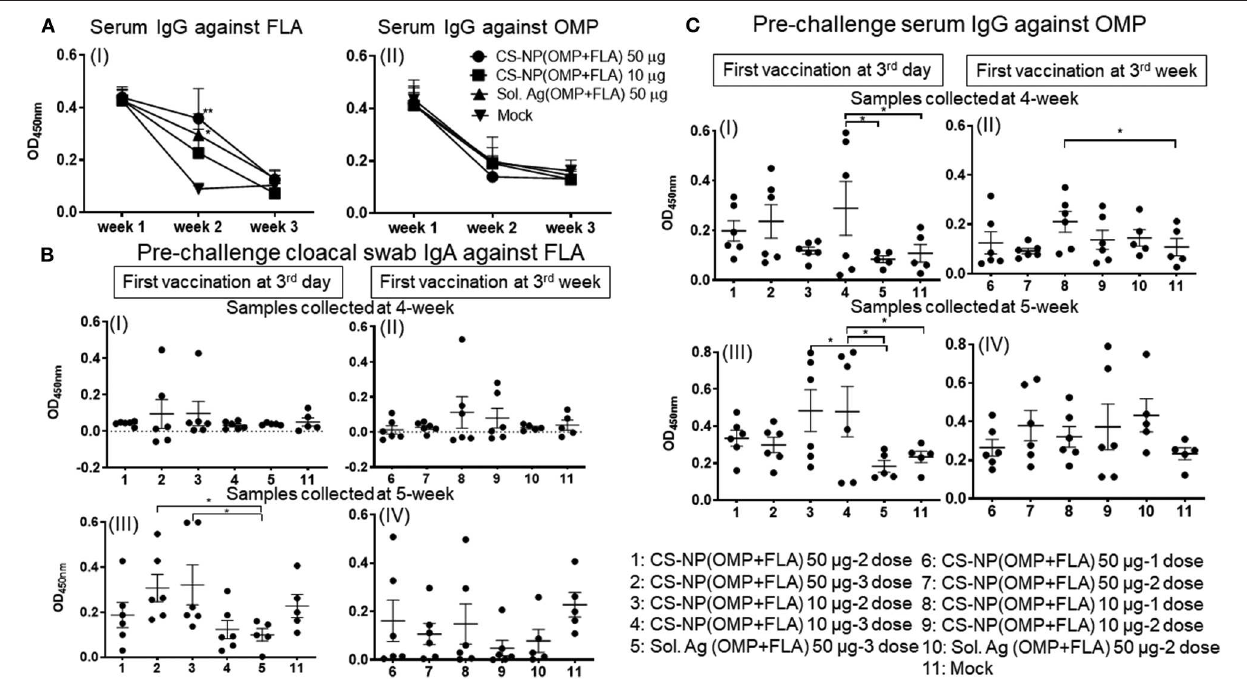
FIGURE 1 | Salmonella specific antibody response post-vaccination and before challenge infection. Broiler birds were vaccinated with CS-NP(OMP + FLA) orally beginning at age 3-day or 3-week, with each dose containing either 10 or 50 µ g OMP + FLA. Control birds received 50 µ g of Sol.Ag(OMP + FLA). Cloacal swab and blood samples collected at different time points post-vaccination were analyzed for detection of specific IgA or IgG antibodies by ELISA. (A) Serum samples collected at age 3-day (week 1, before 1st vaccination), week 2 and week 3 were analyzed for IgG response against (I) FLA and (II) OMP. Significant difference between vaccinated and mock groups was analyzed by two-way ANOVA followed by Tukey post-hoc test. (B) Birds received 1st dose of vaccine at 3rd day (I and III) or at 3rd week (II and IV). Cloacal swabs collected at age 4-week (I and II) and 5-week before SE challenge infection (III and IV) were analyzed for IgA antibody response against FLA protein. (C) Serum samples collected on the same days as described in (B, I–IV) were analyzed for IgG antibody response against OMP. Significant difference between the indicated two groups was determined by one-way ANOVA followed by Tukey post-hoc test. * P < 0.05, ** P < 0.01. Data were presented as mean ± SEM of 6 or 5